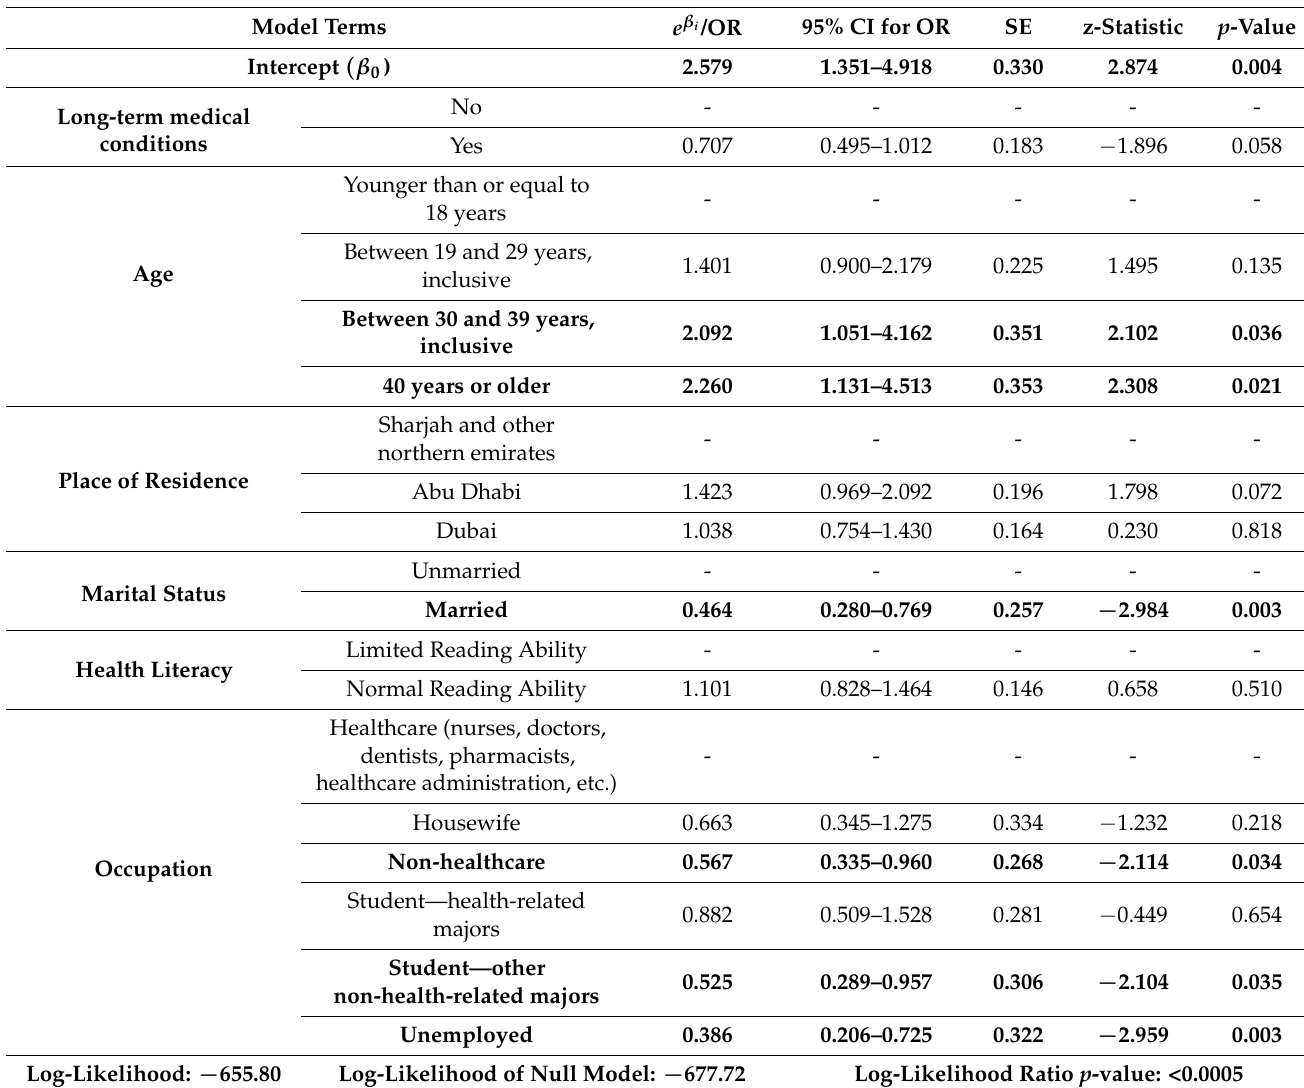
Table 2. The results of the logistic regression modeling the determinants of Internet use as a binary variable exploring its determinants. Rows with significant p values are bolded. OR: odds ration; CI: confidence interval; SE: standard